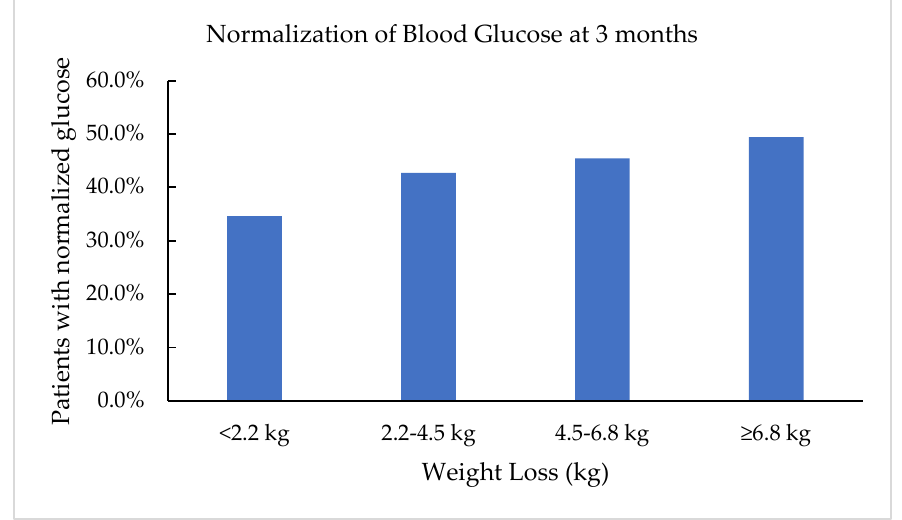
Figure 3. Percentage of patients with normalization of blood glucose levels <100 mg/dL in relation to amount of weight lost at 3 months.